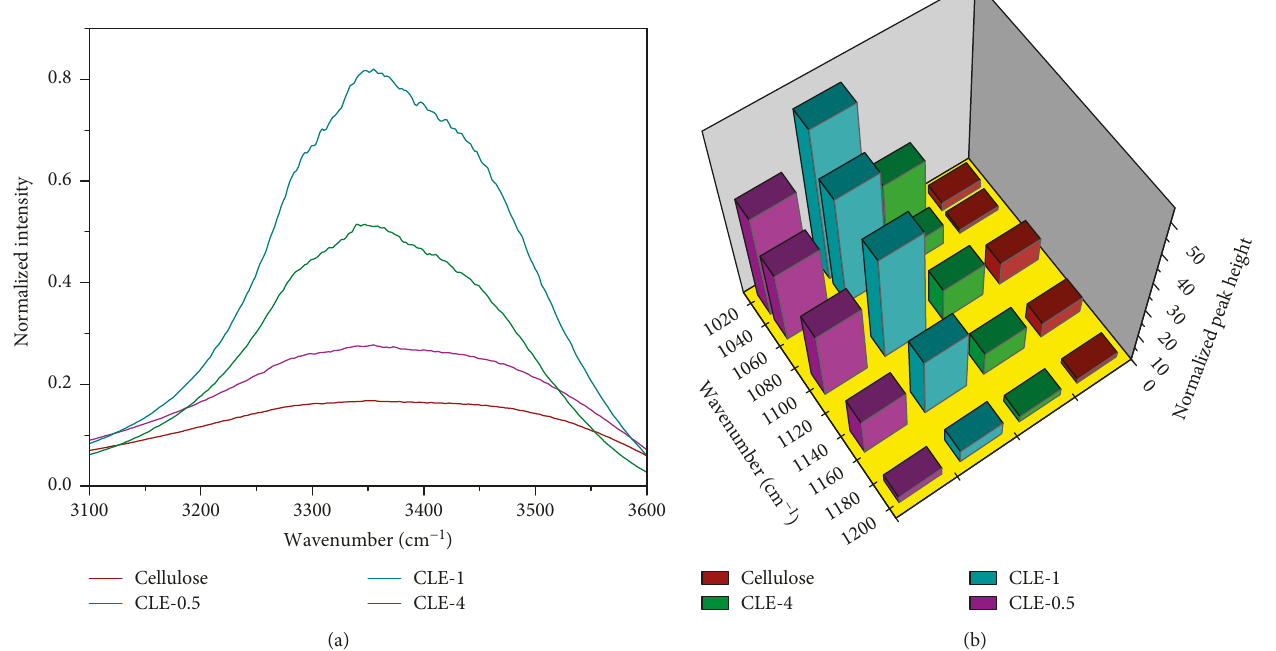
Figure 1: FTIR spectral results for cellulose and its cross-linked polymers: (a) – OH spectral region and (b) C – O peak areas.